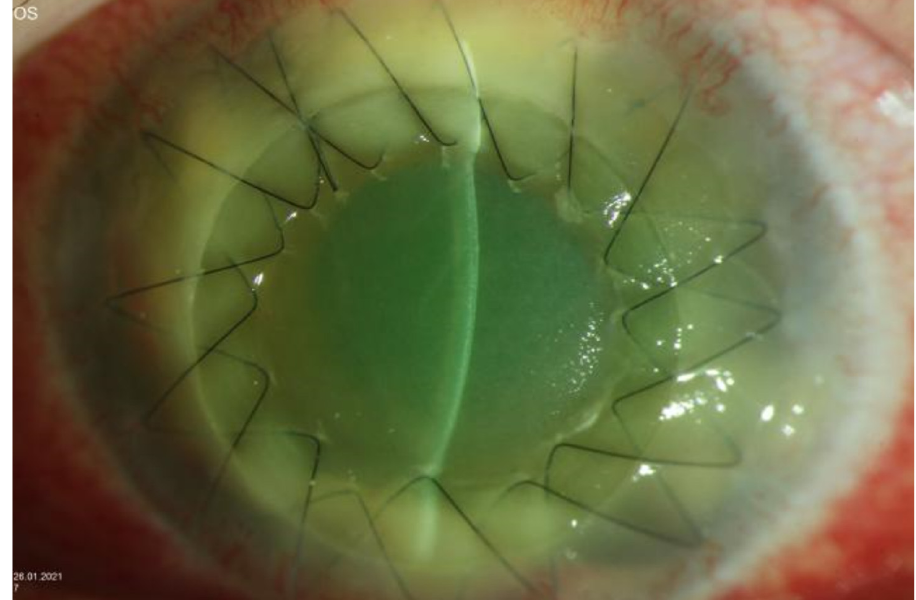
Figure 4. Biomicroscopic slit-lamp photography of the left eye 3 weeks after the first keratoplasty with extended circular infiltration of the host and graft cornea. The epithelial defect is due to repeated corneal abrasion to improve drug penetration.